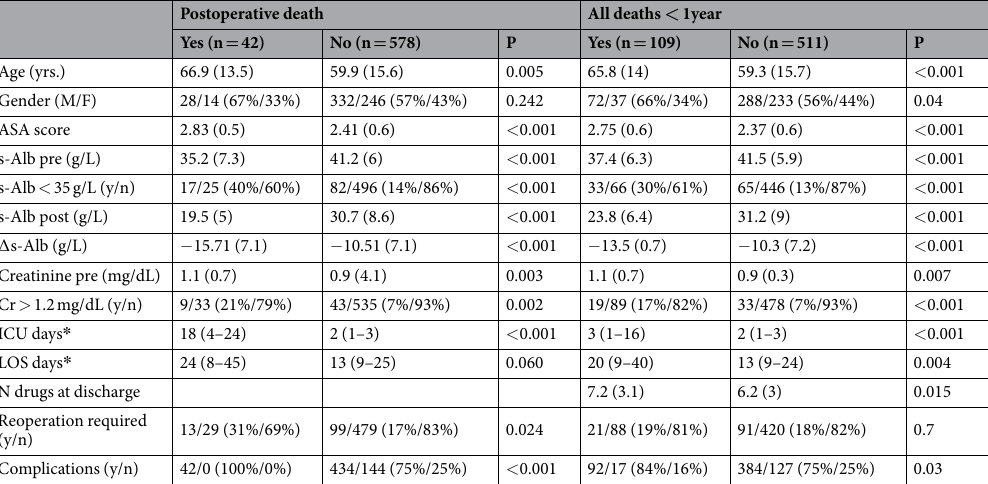
Table 2. Variables associated with postoperative death and one year mortality in complex surgical patients. * IQR (interquartile